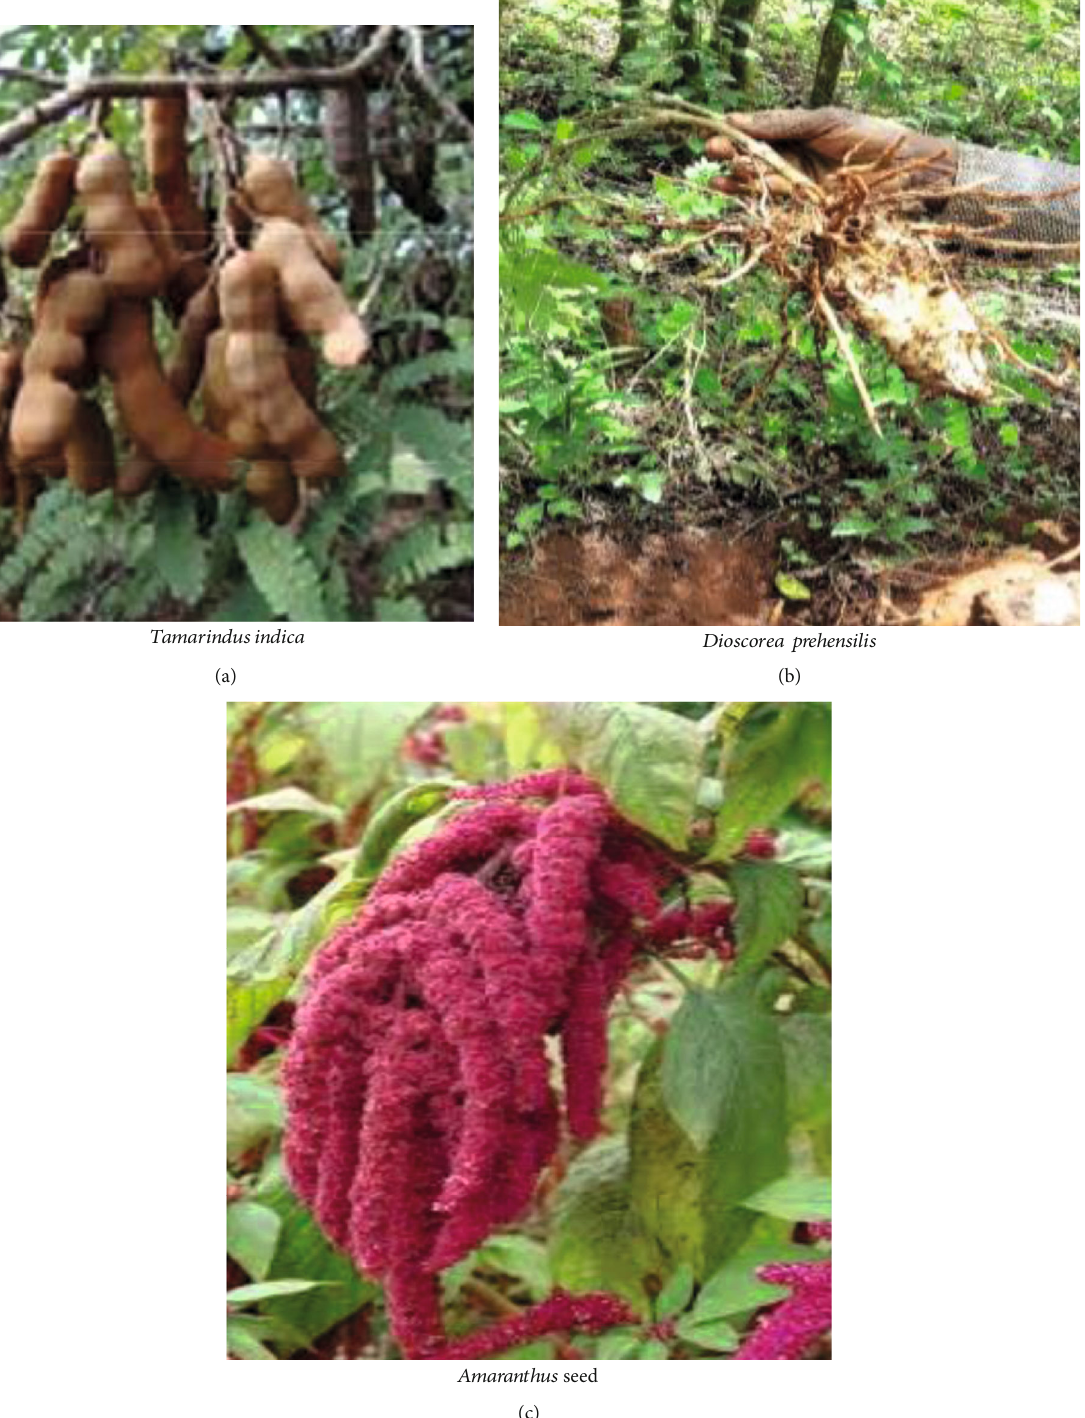
Figure 3: Commonly consumed wild edible tubers (a and b) and seed